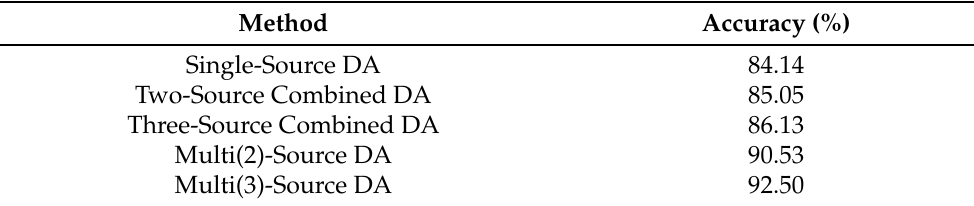
Table 4. Comparison of Performance of Domain Adaptation (DA)